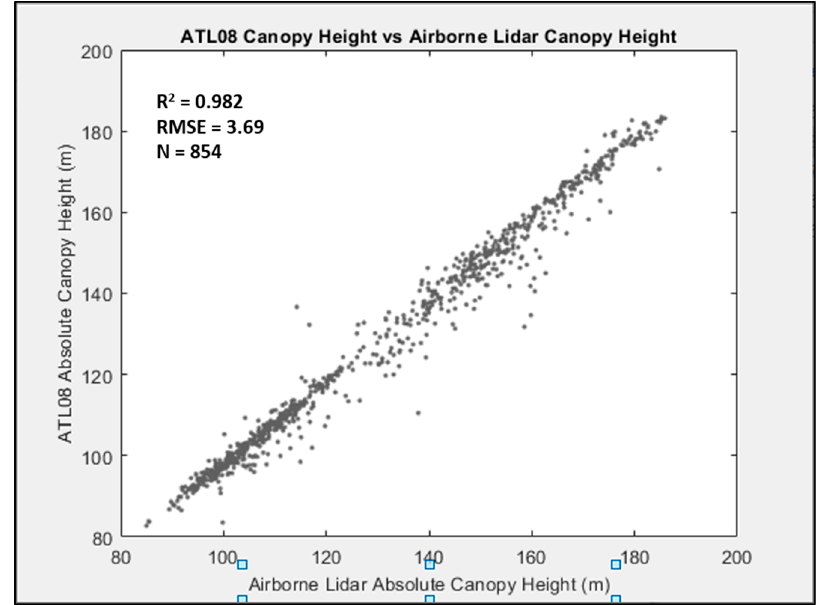
Figure 12. Scatterplot of ATL08 absolute canopy height compared to airborne lidar absolute top of canopy height within the 100 m segment for the full 200 km of analyzed data.